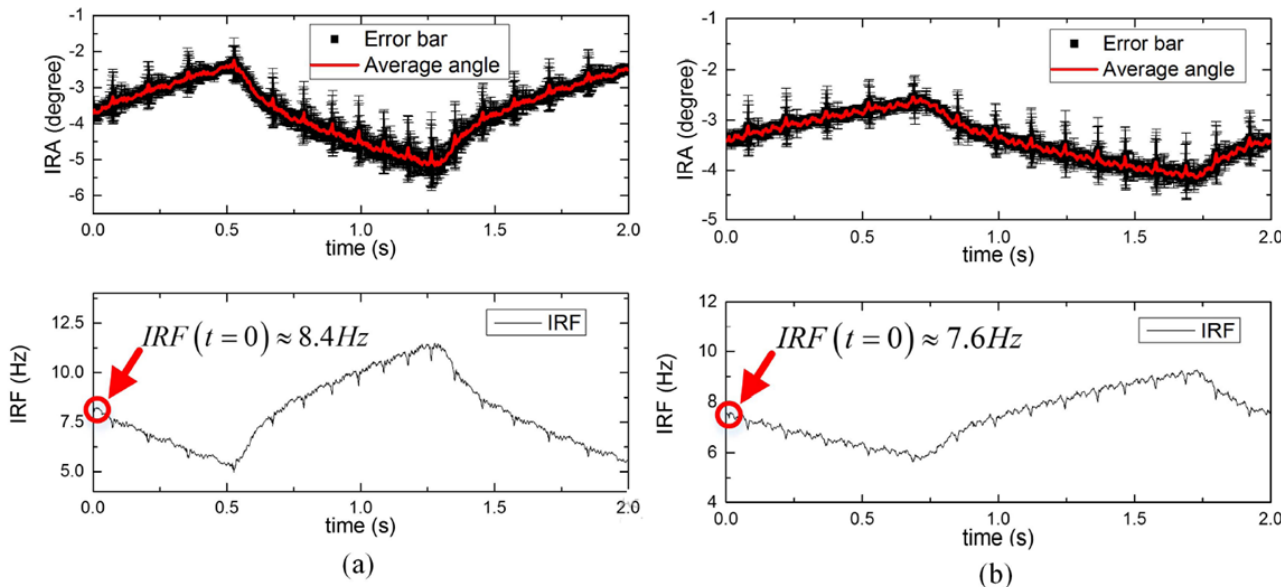
Figure 26. Instantaneous rotating angle (IRA) and instantaneous rotating frequency (IRF) curve for diagnosis of ( a ) outer race bearing fault and ( b ) inner race bearing fault. Reproduced with permission of [73], the initial value of IRF at t = 0 is shown by red circle and arrow.